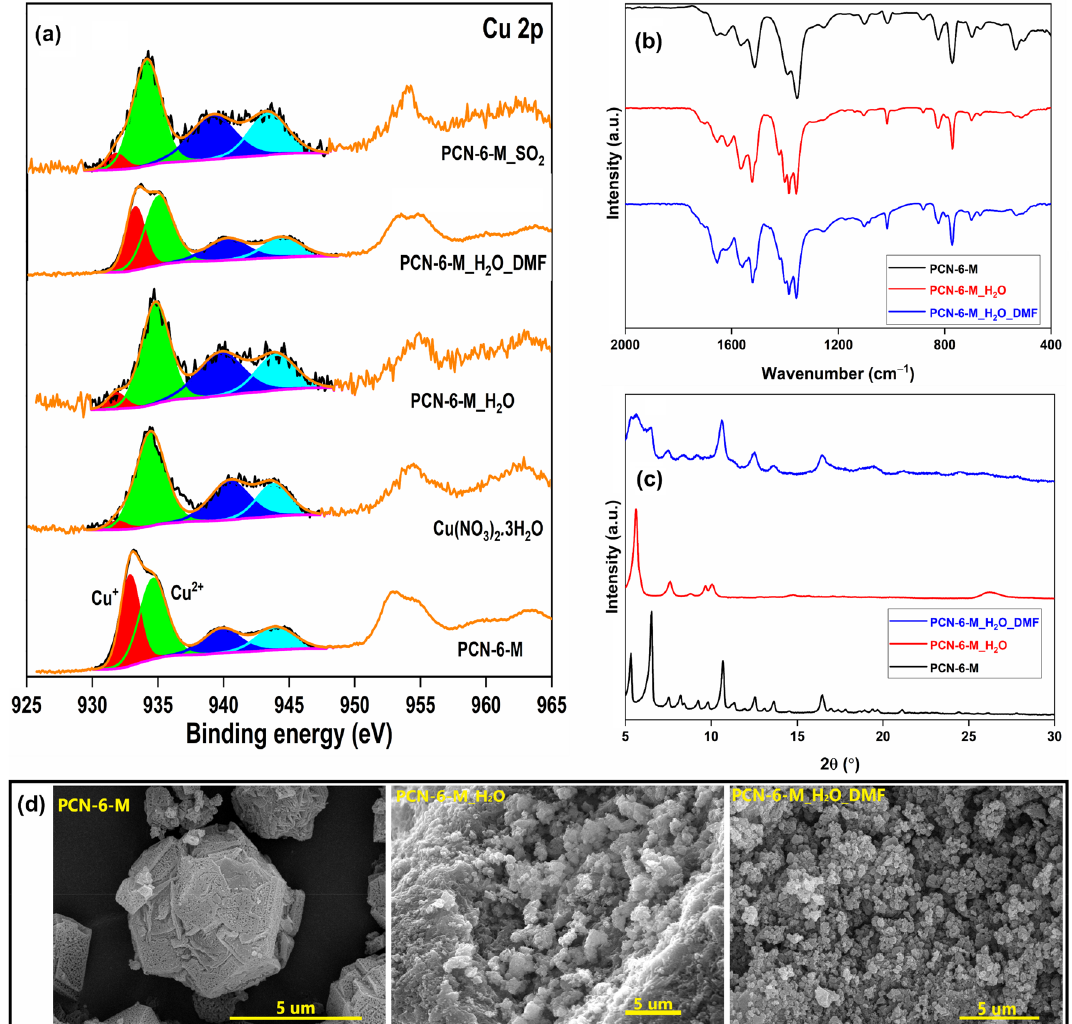
Figure 3. ( a ) HRXPS Cu 2p spectra of PCN-6-M in different environments; ( b ) FTIR spectra; ( c ) PXRD patterns; ( d ) SEM micrographs of PCN-6-M and after soaking in water, followed by soaking in DMF at 343